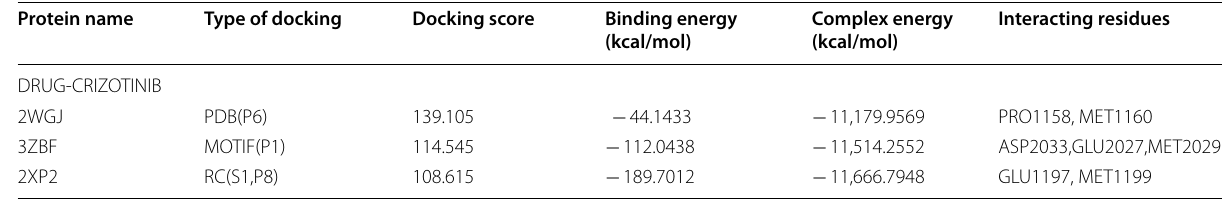
Table 6 Docking result of a best-docked complex of Crizotinib drug with C-MET, C-ROS1 and ALK proteins Protein name